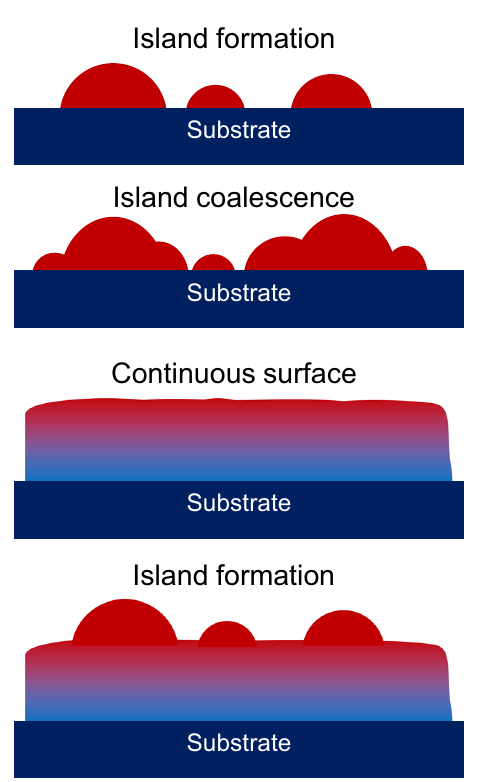
Fig. 5 Island-layer-island growth. The schematic diagram showing the island-layer-island growth of